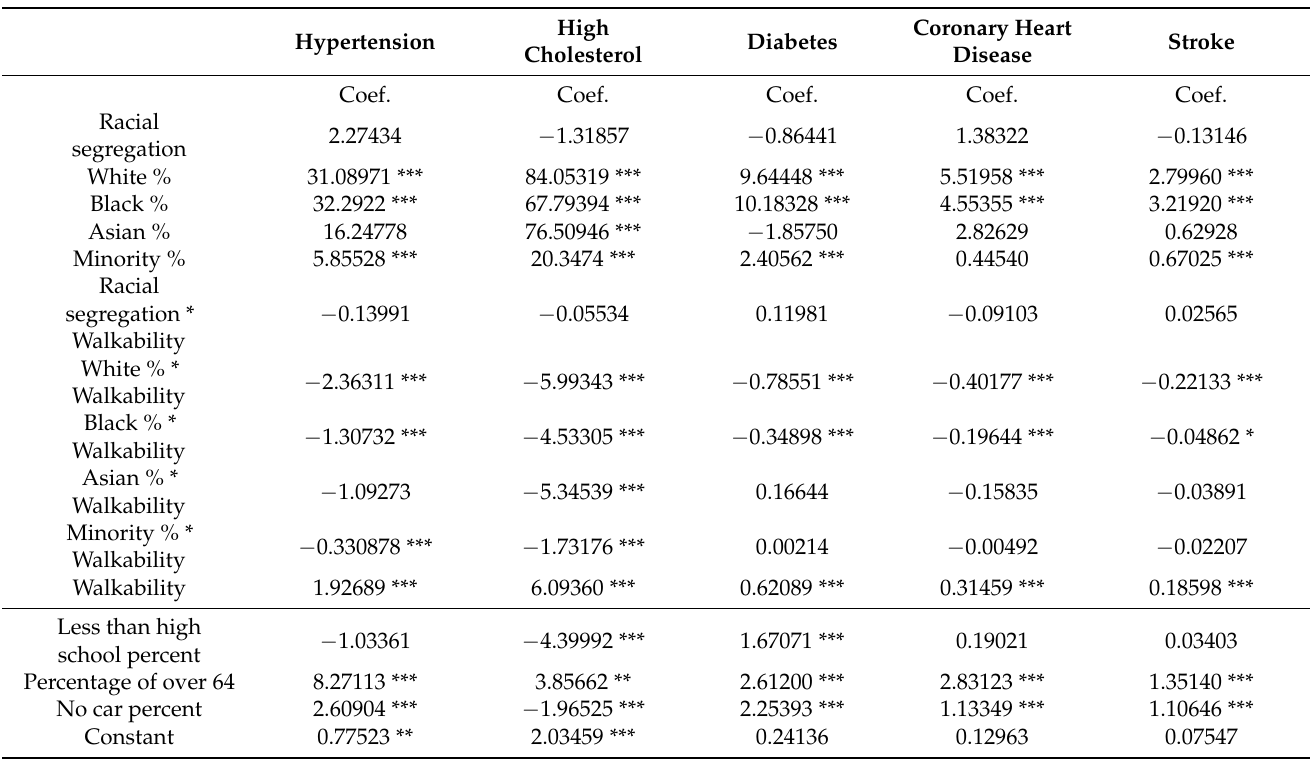
Table 3. Regression model results of health outcomes, racial segregation, and walkability in the Chicago metropolitan area. Coronary Heart High Stroke Diabetes Hypertension Disease Cholesterol Coef. Coef. Coef. Coef.